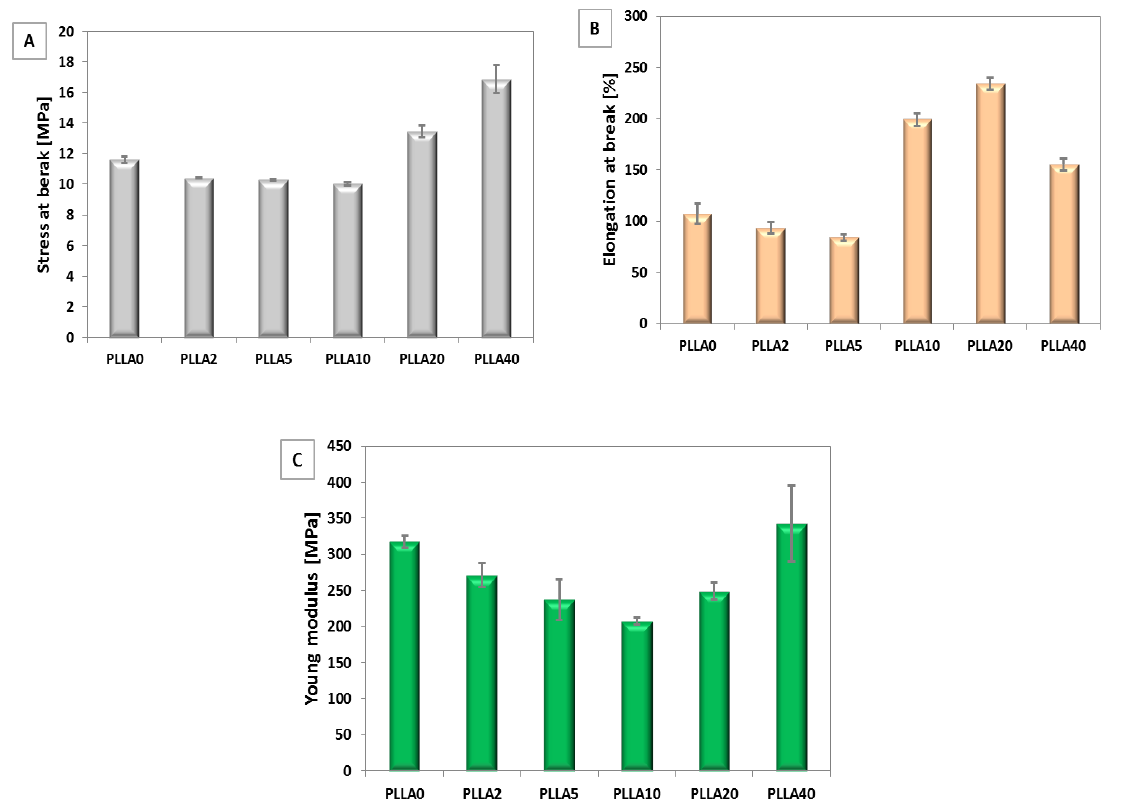
Figure 8. Mechanical properties of bicomponent fibres with additive PGSu to PLLA: ( A ) stress at break, ( B ) elongation at break, and ( C ) Young’s